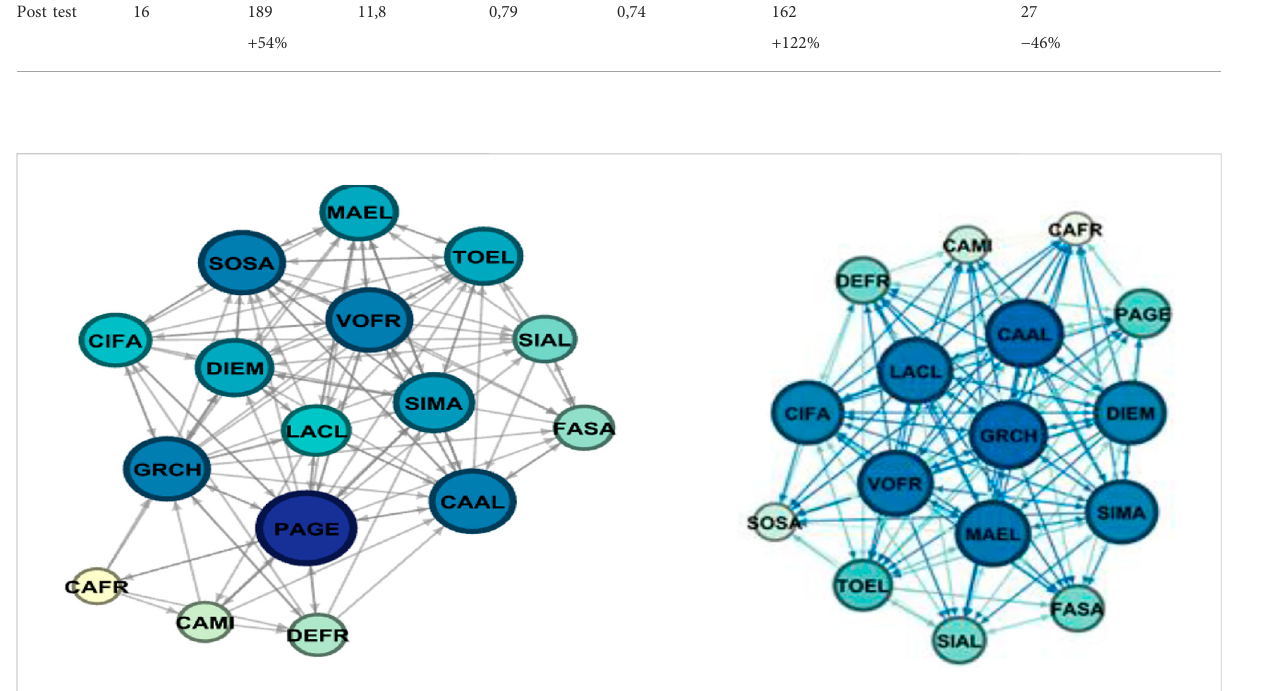
FIGURE 2 Pre-Test (on the left) and post-test (on the right) Sociograms on group organization dimension for the group involved in the